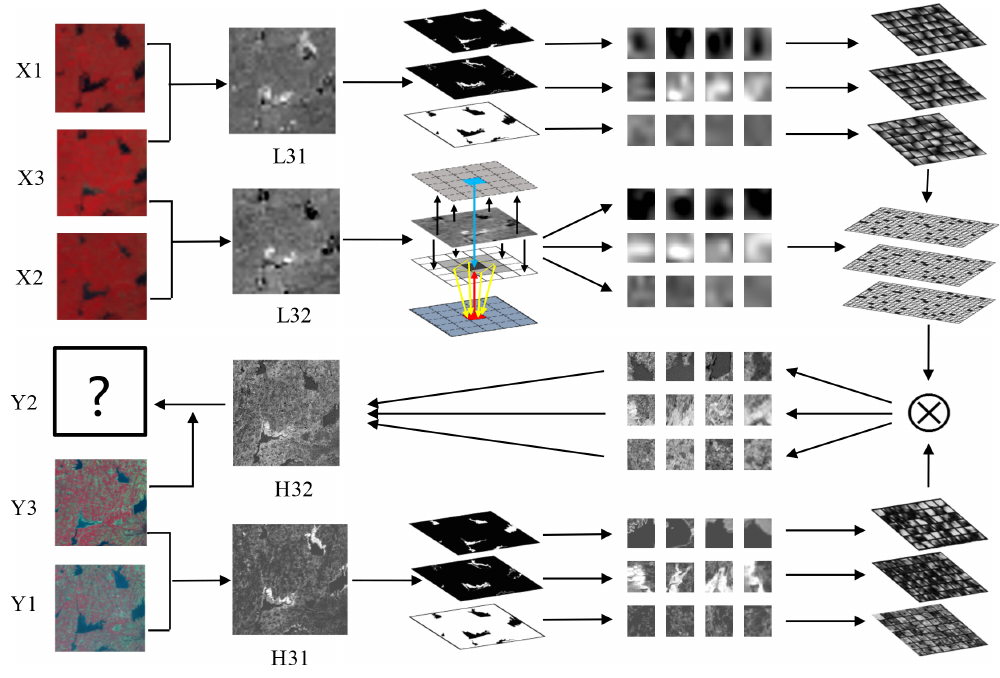
Figure 5. Block diagram of